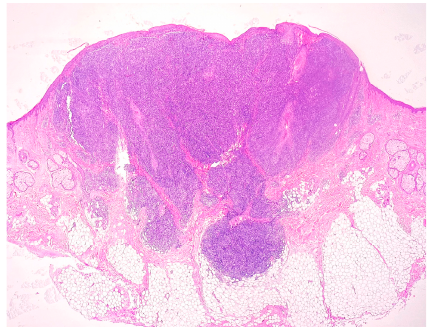
Figure 2. HE staining. Magnification 20×.